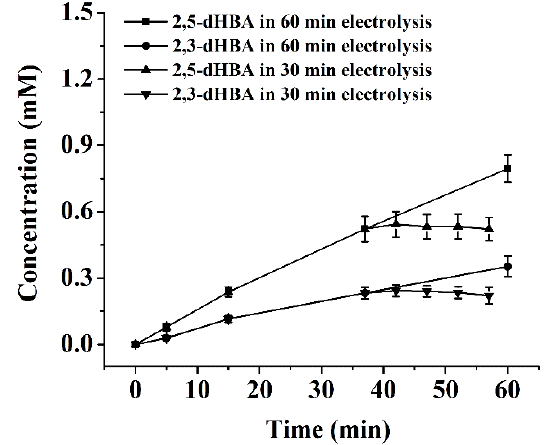
Figure 4. 2, 3-dHBA and 2, 5-dHBA production versus time in electro-Fenton process.